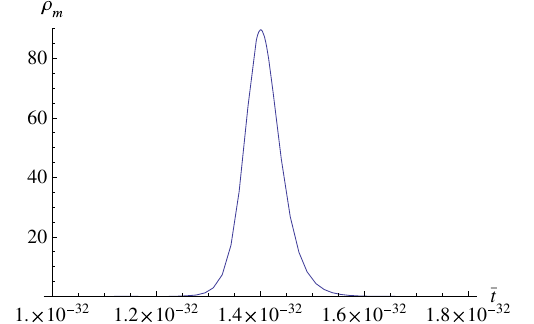
¨ Φ Fig. 3 The diagram presents the evolution of ¯ H ˙ Φ with respect to the cosmological time ¯ t . The time is expressed in seconds. The value of the parameter γ is assumed as 3 . 277 × 10 − 6 s 2 Mpc 2 . We also assume that km 2 ¨ Φ Λ = 0 . 6911, where H = 67 . 74 km .Notethat 0 ¯ H ˙ Φ isnotaconstant s Mpc 3 H 2 0